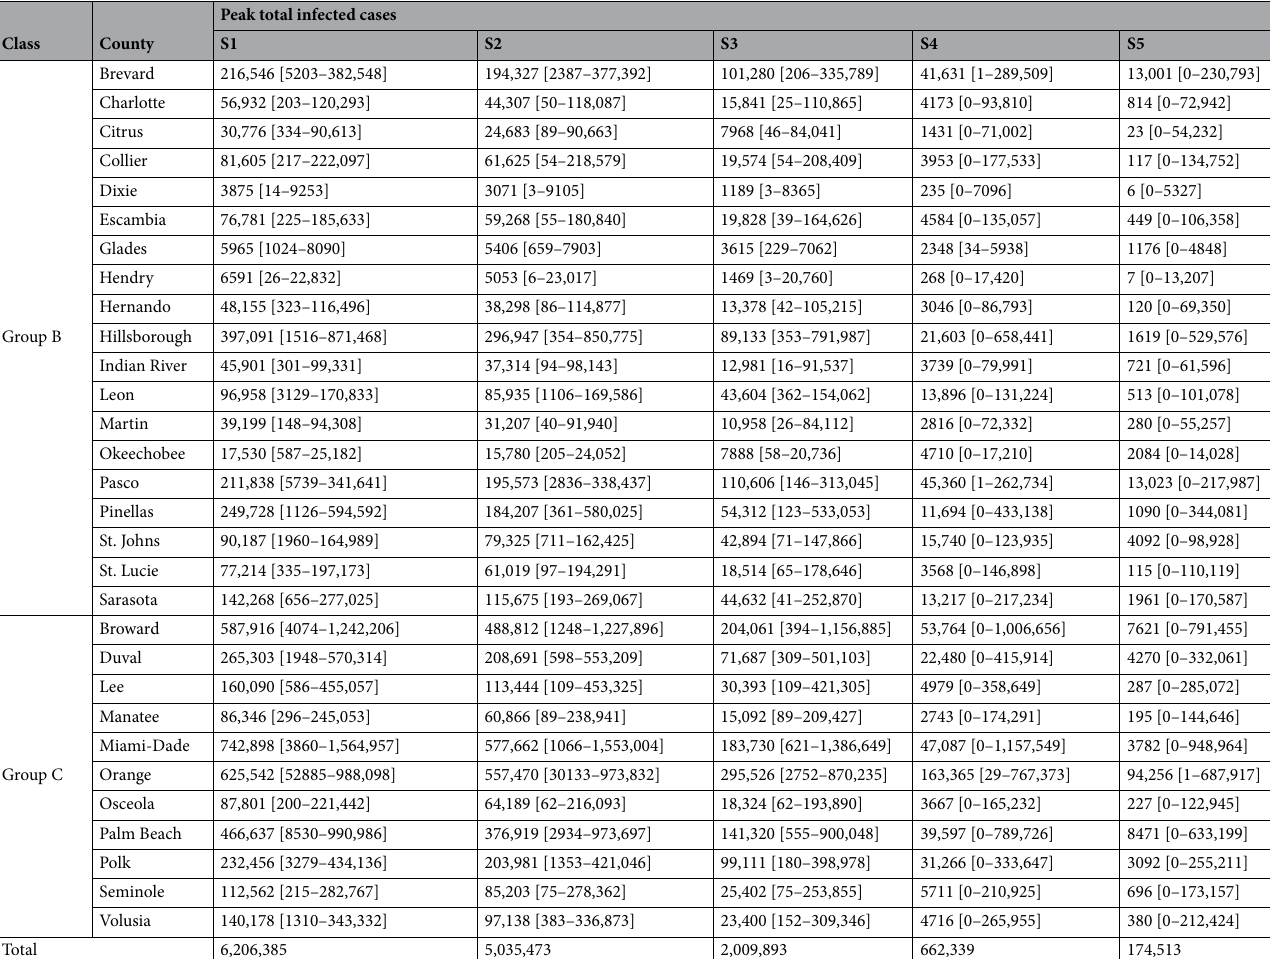
Table 1. Total median infected cases predicted at the epidemic peak in each county. The 90% confidence interval is given in brackets. Counties are stratified by initial county-level incidence growth